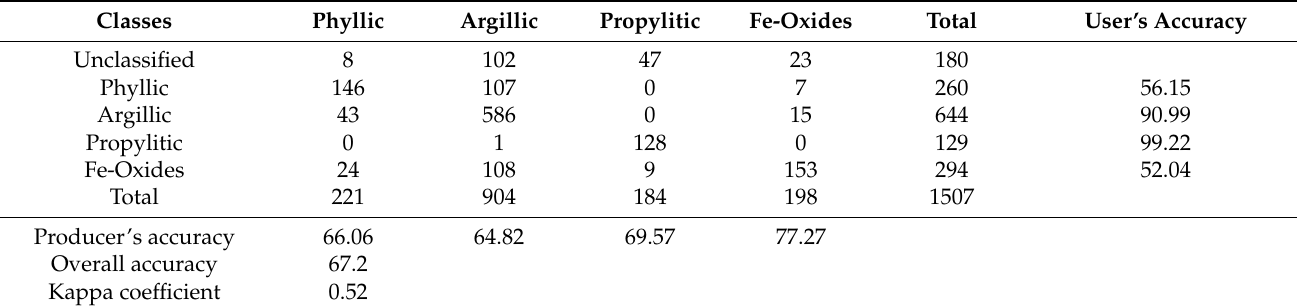
Table 2. Confusion matrix for the SAM